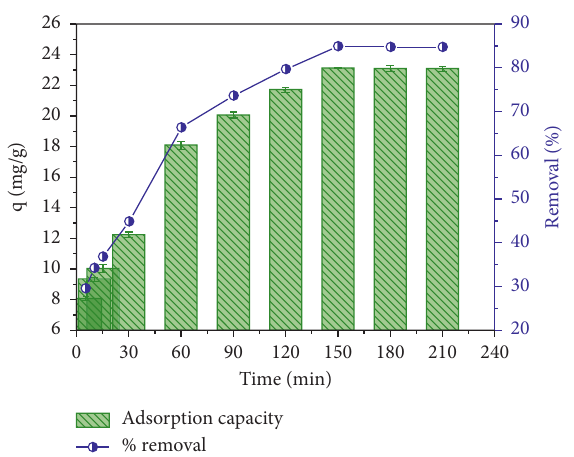
Figure 5: Effects of contact times on RhB adsorption by CAC/ CoFe 2 O 4 200 at 50 mg/L initial RhB concentration, adsorbent dosage of 0.05 g CAC/CoFe 2 O 4 200/25 mL RhB, and initial pH of